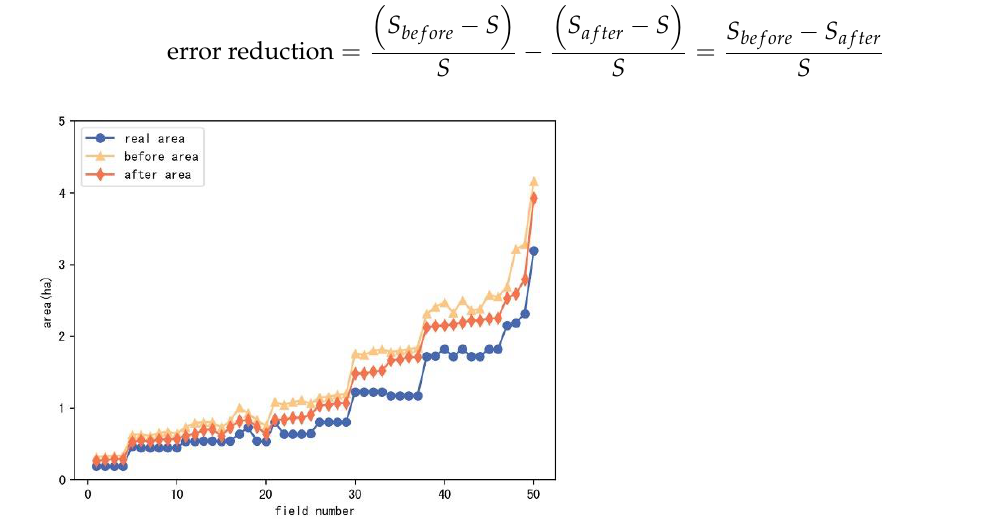
for the trajectory data of 50 fields.